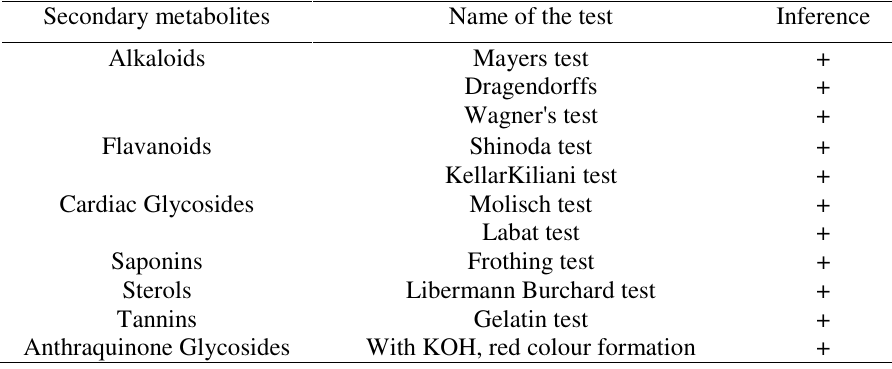
Table 2. Preliminary screening of secondary metabolites from rhizome of Costus